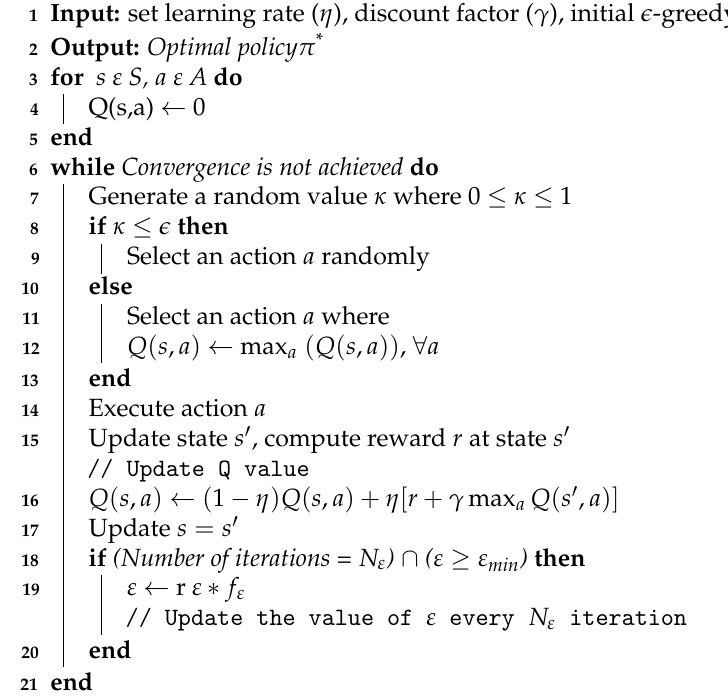
Algorithm 2: Q-learning based algorithm for dynamic selection of N